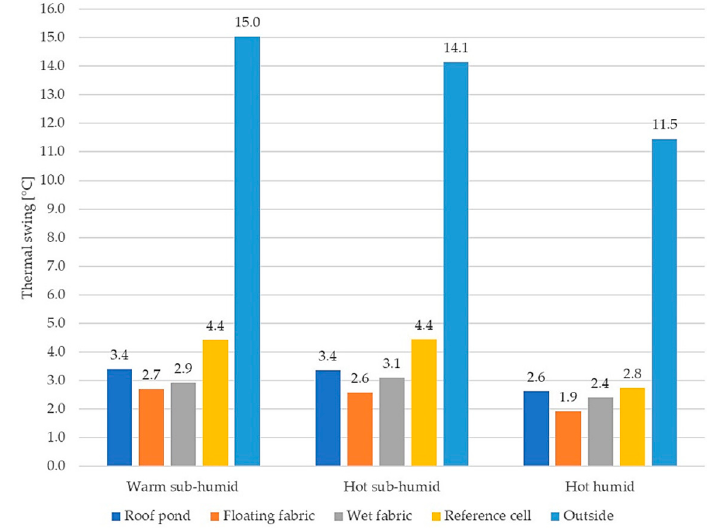
Figure 15. Thermal swing of all cases in the three climatic conditions.